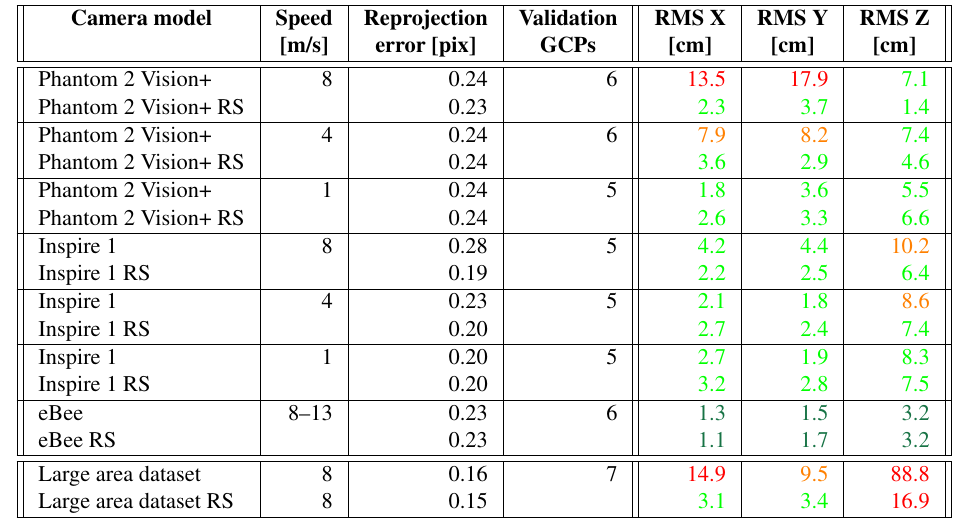
Table 3: Comparison of the camera models with and without rolling shutter (RS) block adjustment for various cameras and flight speeds recorded at our test site. Of the 12 GCPs available, 6 were used for the calibration and 5-6 were used as validation GCPs (one was sometimes occluded). The GSD of the datasets is always around 2 . 85cm . The RMS error is reported on the validation GCPs. For the RMS errors, the following color coding was applied: horizontal X and Y axes: green ≤ 2 GSD < orange ≤ 3 GSD < red; vertical Z axis: green ≤ 3 GSD < orange ≤ 4 GSD < red. The large area dataset is the one shown in Fig.